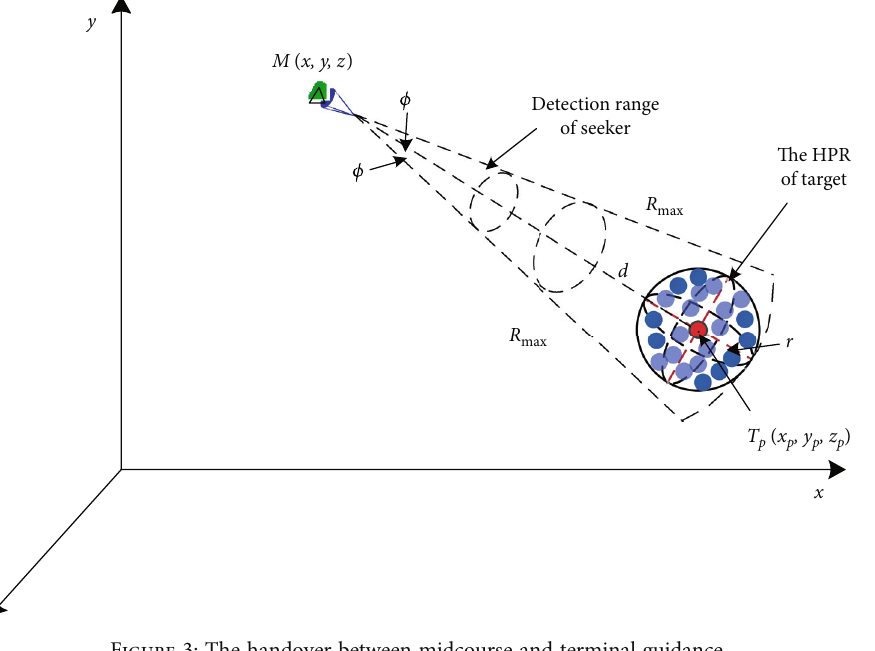
Figure 3: The handover between midcourse and terminal